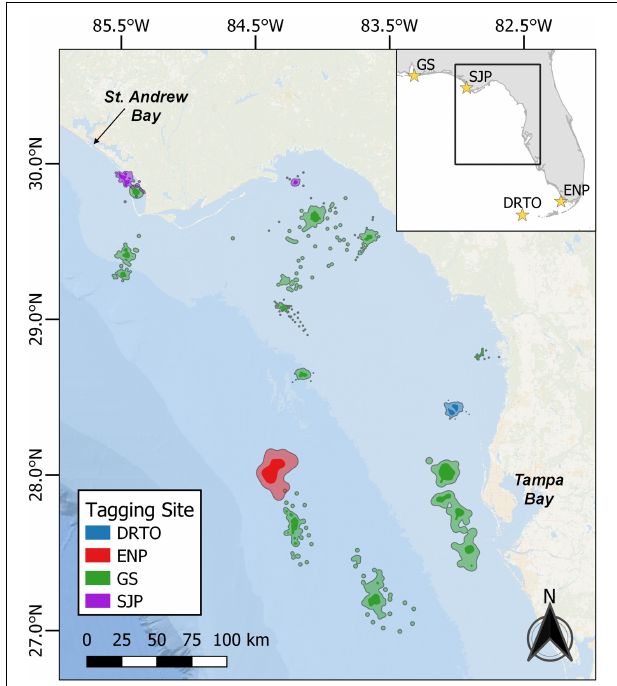
FIGURE 1 | Home range and core-use areas for loggerhead sea turtle ( Caretta caretta ) foraging periods occurring within the Big Bend region (inset box), from Tampa Bay to St. Andrew Bay. Tagging locations are shown as yellow stars on the inset map; turtles were satellite-tagged at four sites in the Gulf of Mexico and colors correspond to tagging location: Dry Tortugas National Park, Florida (DRTO, n = 1, blue); Everglades National Park, Florida (ENP, n = 1, red); Gulf Shores, Alabama (GS, n = 11, green); St. Joseph Peninsula, Florida (SJP, n = 2, purple). Kernel Density Estimates (KDEs) are shown for each turtle as lighter polygons (95% KDE; home range) with a darker color inside (50% KDE; core-use